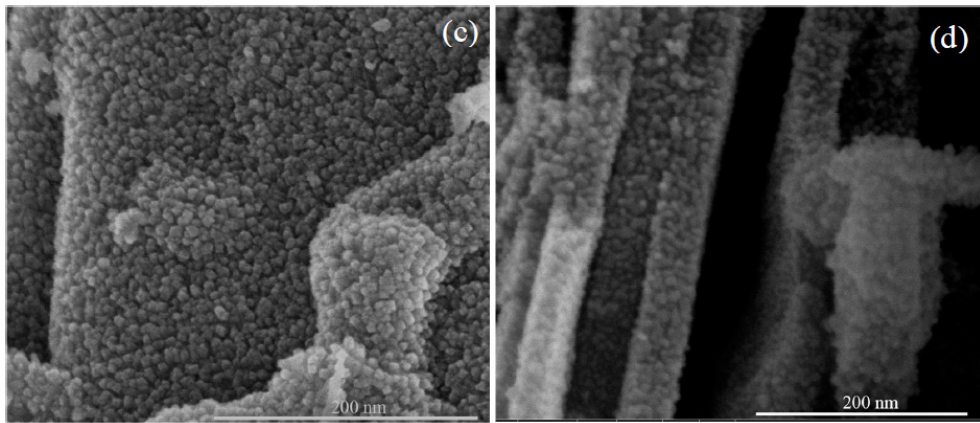
Figure 3. FESEM images of as-prepared SnO 2 nanosheets. ( a ) Panoramic top-view image. ( b ) FESEM image. ( c ) High-magnification FESEM images. ( d ) Cross-sectional image.